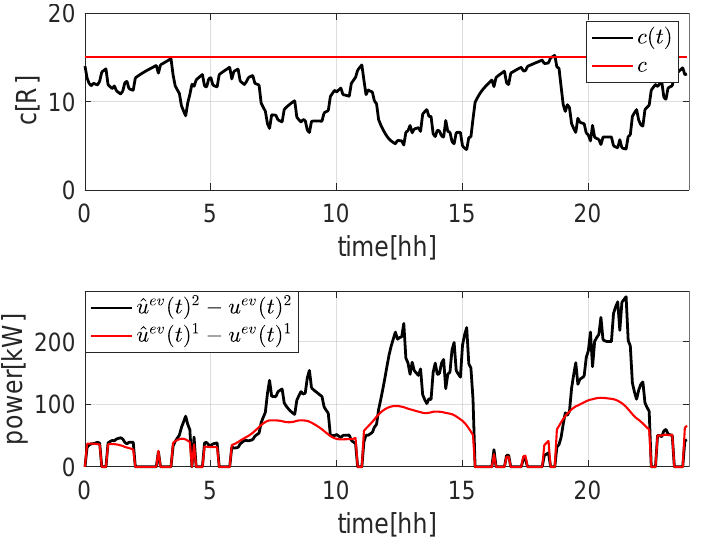
Figure 5. Evolution of mismatch between power demand for charging PEVs ( ˆ u ev ( t ) ) and power delivered to PEVs ( u ev ( t ) ). · 1 is computed with fixed c = 15; · 2 is computed with c ( t ) , as in